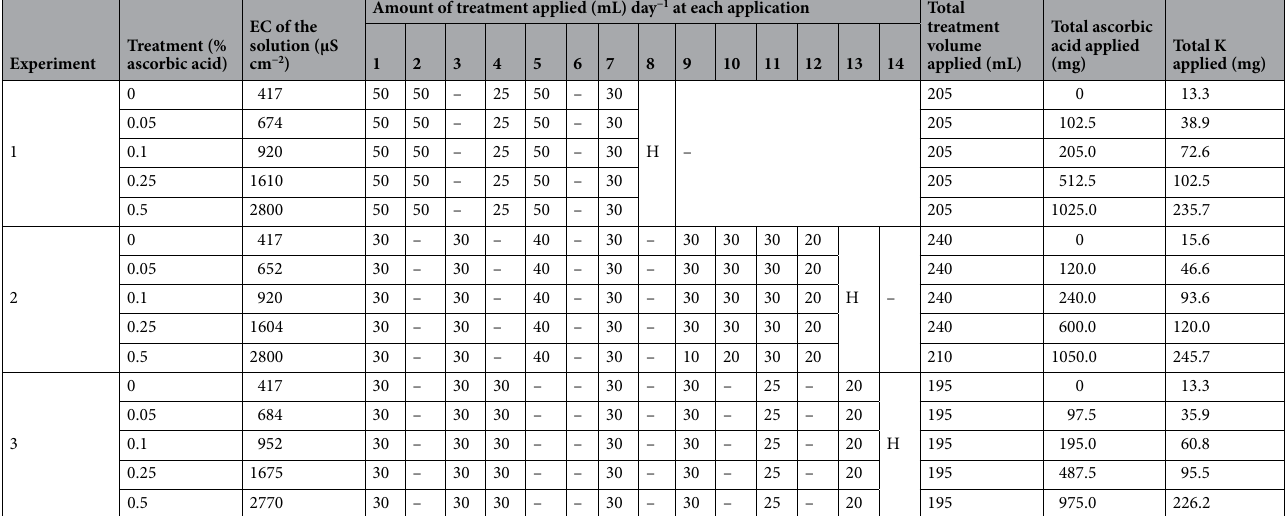
Table 5. Amount of water and ascorbic acid applied to microgreens in each treatment. Treatments were started after the appearance of cotyledons and terminated at harvest. Cells marked with ‘H’ indicate when microgreens were